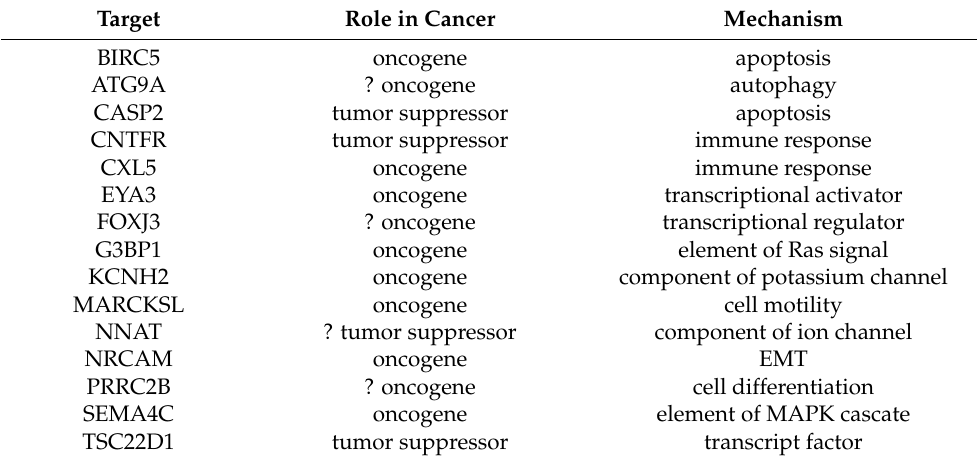
Table 1. Information about the role and main mechanism in cancer cells of miR-708 validated targets expression (shared at least between two databases).